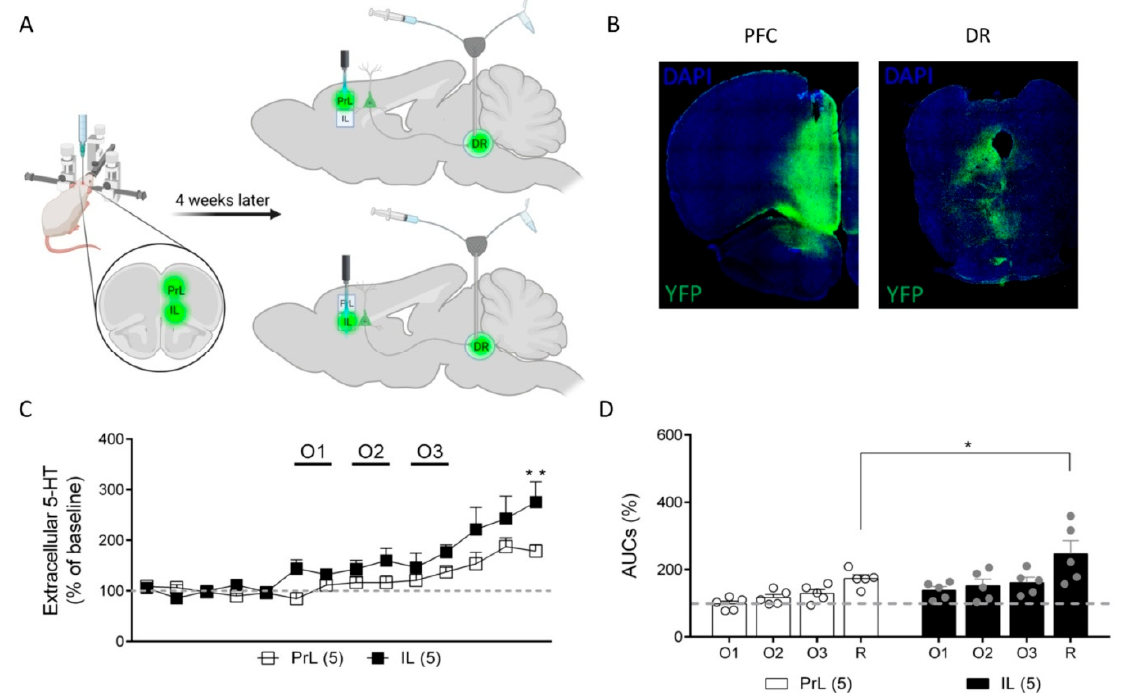
Figure 7. Effect of IL and PrL optogenetic stimulation (O1: 1 Hz, O2: 10 Hz, O3: 20 Hz, 5 ms pulse width, and ~5 mW at the fiberoptic tip) on extracellular 5-HT concentration in DR. ( A ) Schematic representation of the experimental protocol used. ( B ) Representative fluorescent image of a coronal slice of a rat brain at the level of AAV injection site (mPFC, left panel) and at the microdialysis probe implant site (DR, right panel). Note the intense fluorescence in DR, indicating a successful expression ofAAV-CHR2-YFP by mPFC-DR descending axons. ( C ) Graph showing data as % of basal 5-HT values averaged from five pre-stimulation samples. Note that optogenetic stimulation of both IL and PrL enhanced 5-HT release in the DR in a frequency-dependent manner. More marked effects were found 30 min after the end of IL stimulation. ( D ) Bar graph showing that similar results were found when data were analyzed as normalized areas under curve (AUC) corresponding to each stimulation (O1–O3) and recuperation (R, samples 12–14) periods. * p < 0.05; ** p < 0.01 vs. PrL .